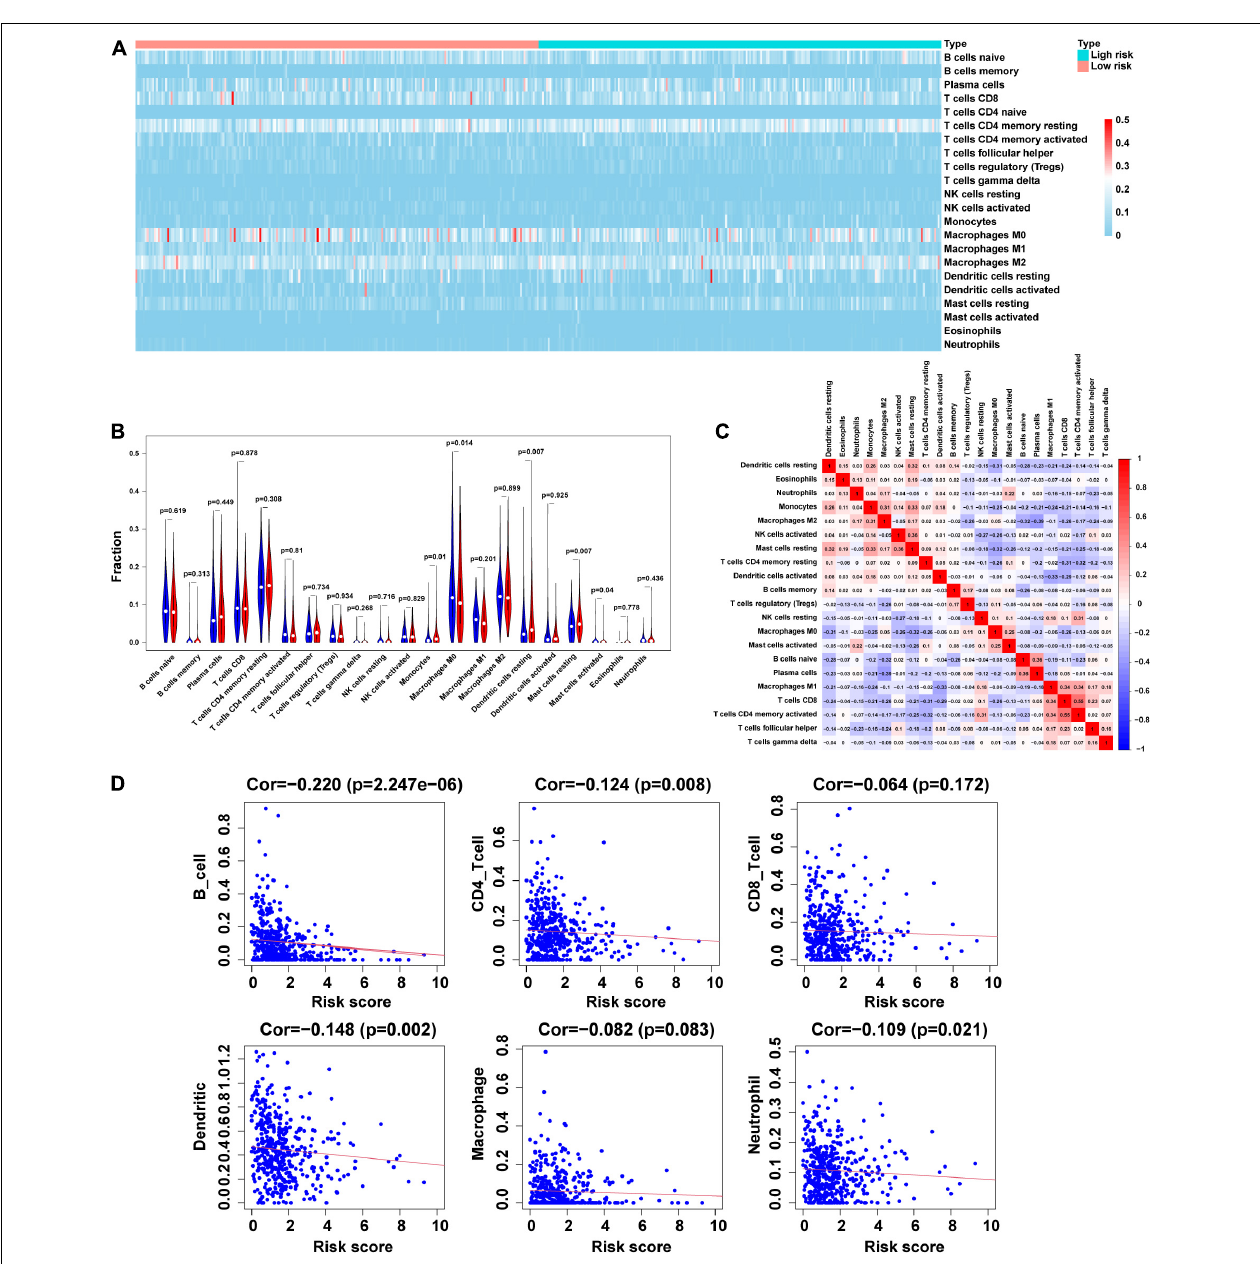
FIGURE 7 | Correlation between tumor-infiltrating immune cells and risk model. (A,B) Heatmap and violin plot of 21 tumor-infiltrating immune cell types in low- and high-risk groups. (C) Spearman correlation analysis of 21 tumor-infiltrating immune cells. (D) Correlation of risk score with 6 tumor-infiltrating immune cell subtypes.